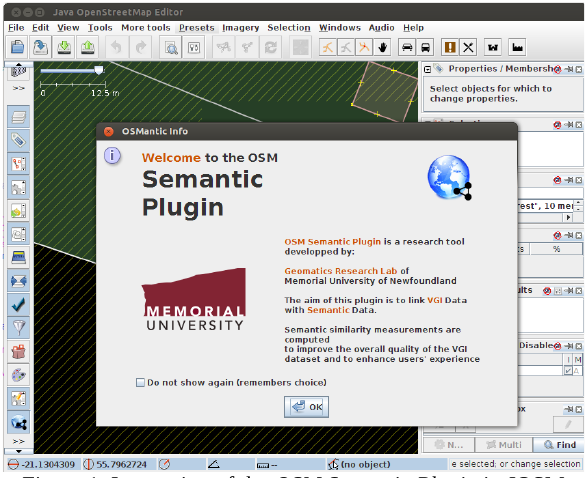
Figure 1. Integration of the OSM Semantic Plugin in